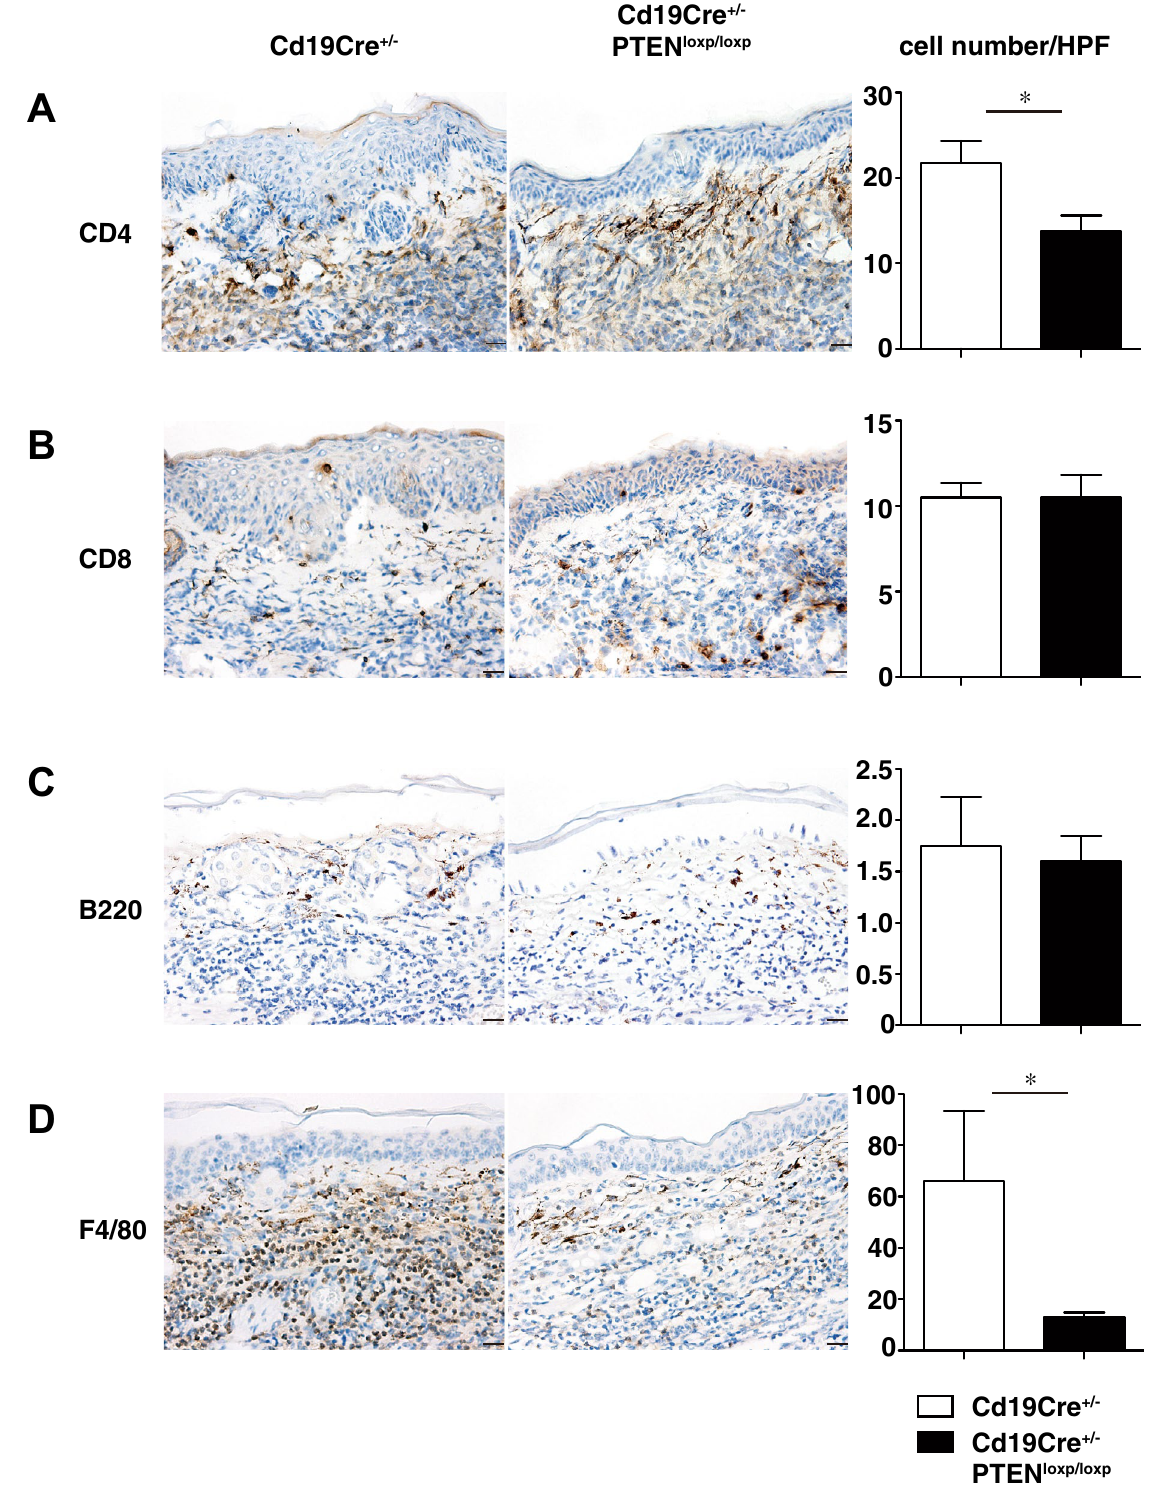
Figure 2. Cell infiltration of rmIL-23-injected ears was decreased in B cell-specific PTEN-deficient mice. Immunohistochemical staining of skin section from rmIL-23-injected ears in Cd19Cre + /− and Cd19Cre + /− Pten loxP/loxP mice (original magnification × 400; bars = 20 μm). The number of CD4 + T cells ( A ), CD8 + T cells ( B ), B cells ( C ) and F4/80 + macrophages ( D ) per field of view (× 400) were counted. Values represent means ± SEMs. Significant differences between samples means are indicated as: * P < 0.05, *** P <